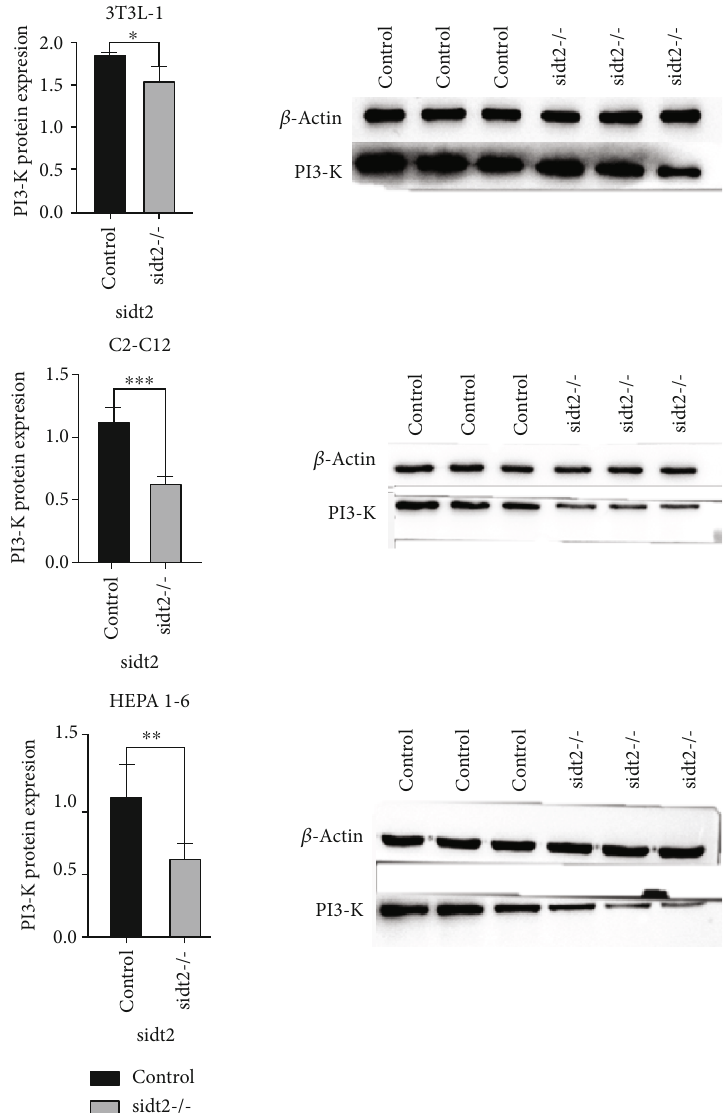
Figure 4: WB results of three cell lines ( ∗ : P < 0 : 05 , ∗∗ : P < 0 : 03 , ∗∗∗ : P < 0 : 01 ). The statistical chart shows that the expression of PI3-K (P85) in the sidt2 knockout group is lower than that in the control group, and the di ff erence is signi fi